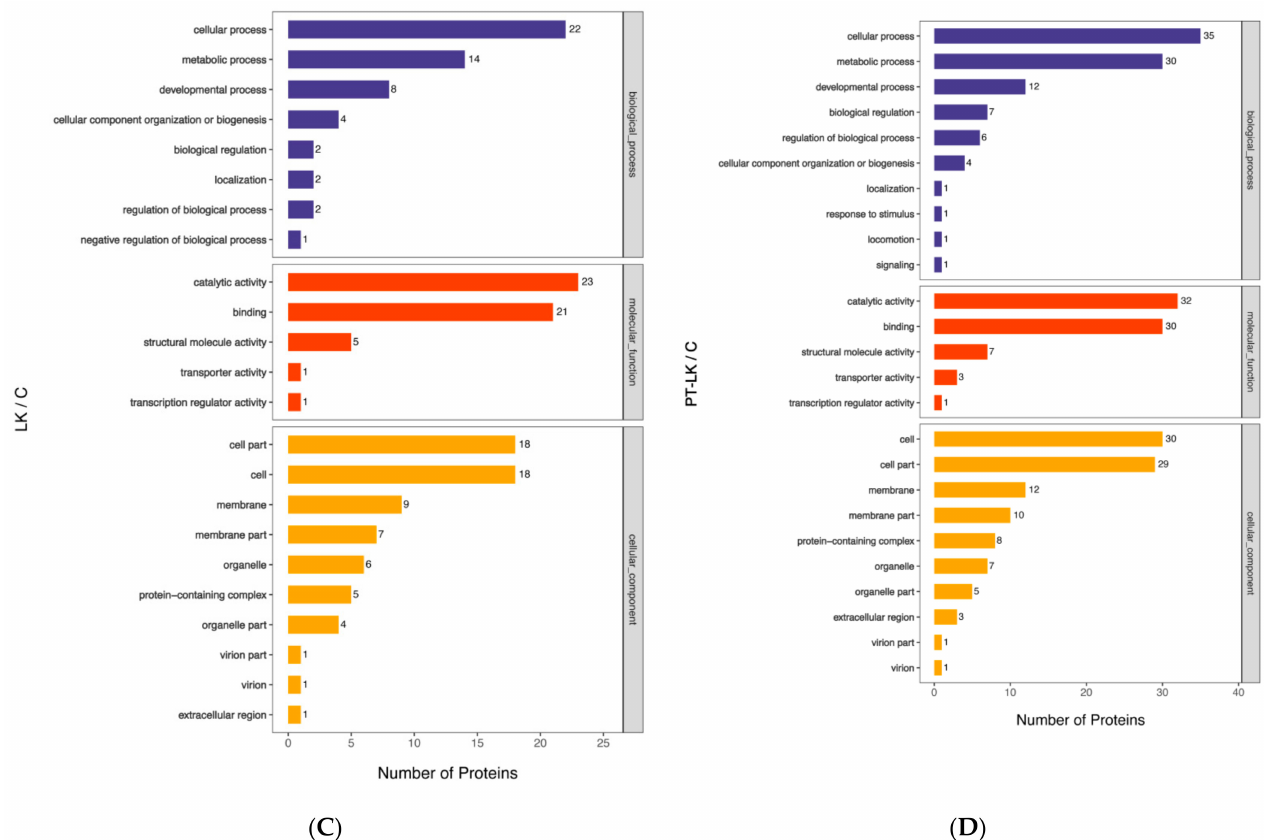
Figure 7. Functional categorization based on GO level 2 analysis of significantly differentially abundant B. subtilis spore proteins after different treatments: ( A ) P/C, ( B ) T/C, ( C ) LK/C, and ( D )